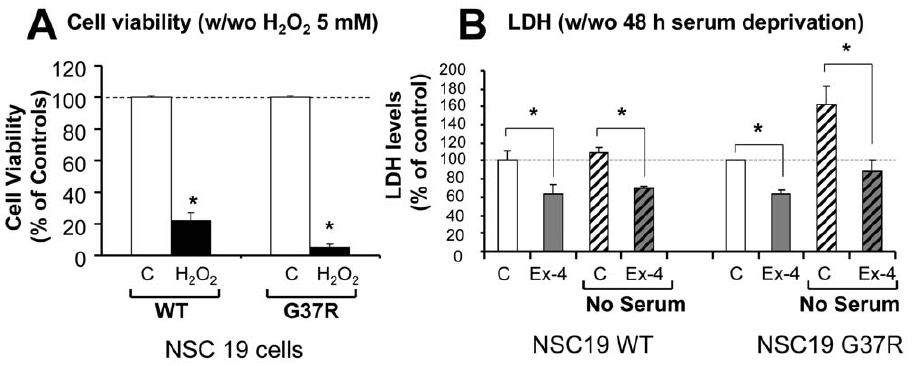
Figure 3. Ex-4 is neuroprotective in NSC19 cells expressing either WT SOD1 or G37R SOD1. ( A ) G37R SOD1 NSC19 cells are more vulnerable to oxidative stress (H 2 O 2 (5 mM) for 24 h) than are WT SOD1 NSC19 cells. Cell viability assessed by MTS assay shows 22% cell survival in WT SOD1 cells v.s. 5% survival in G37R SOD1 cells (n=6, * p , 0.05). ( B ) Ex-4 reduced cell membrane permeability and protected cells from serum deprivation in both WT SOD1- and G37R SOD1-expressing NSC19 cells. Cells were cultured in no-serum media for 48 h in the presence and absence of 100 nM Ex-4. Cell viability was assessed by LDH assay. LDH levels were significantly reduced by Ex-4 treatment in both cells, under conditions of either Ex-4 alone or Ex-4 plus no-serum stress (C: vehicle-treated control; Ex-4: exendin-4; no serum: serum deprivation, n=5, * p ,